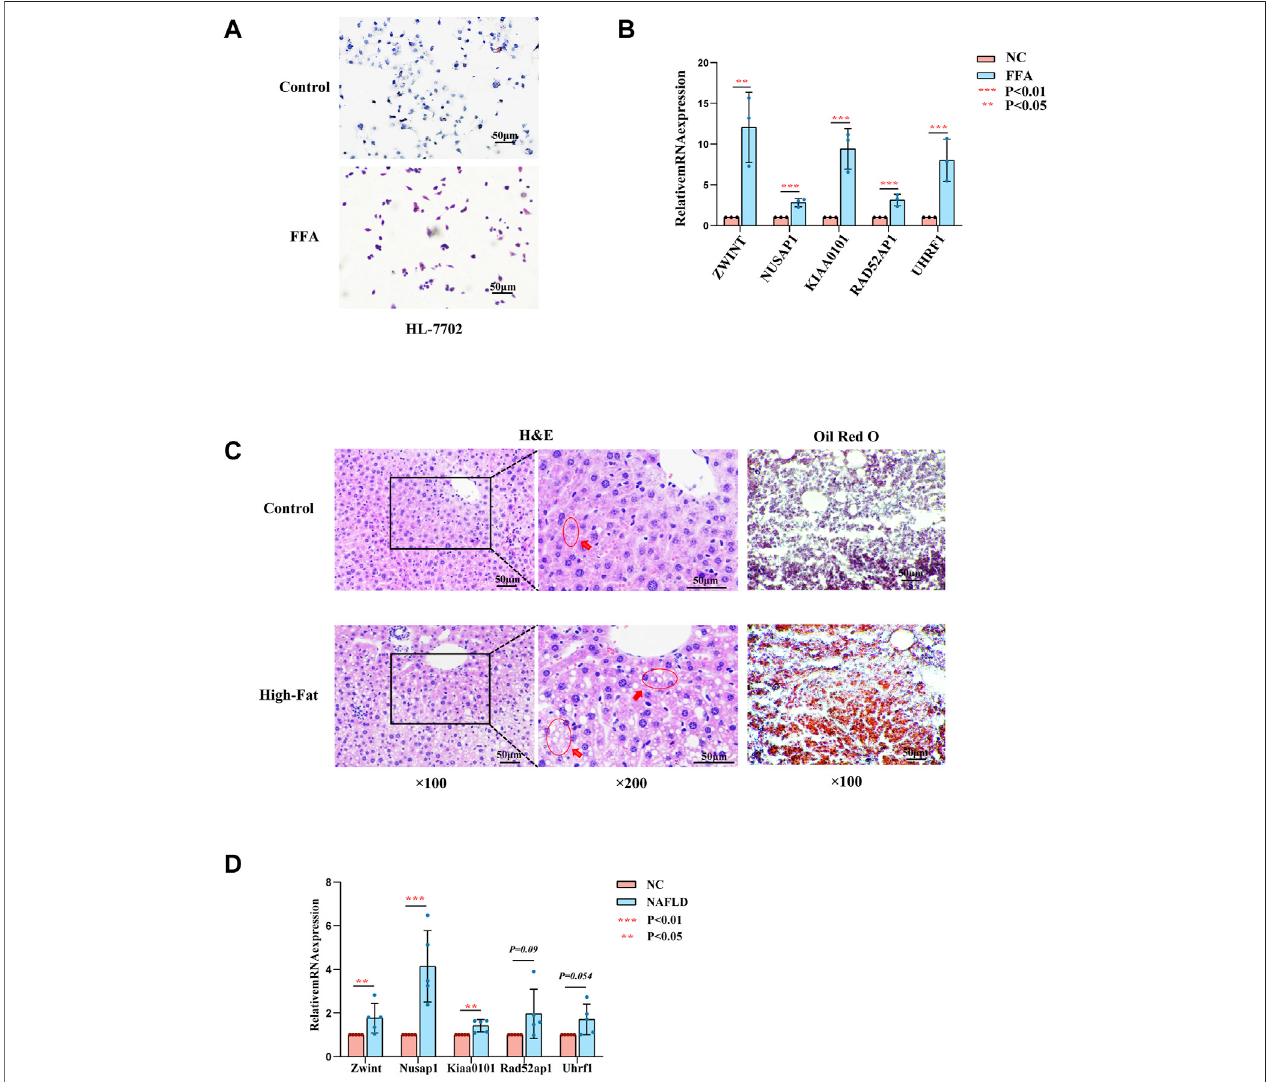
FIGURE 5 | Experiments in vitro and in vivo . (A) Represent Oil Red O staining of HL-7702 cells treated with or without FFA for 24 h. (B) Expression levels of hub genes in HL-7702 cells treated with FFA for 24 h was assessed by RT-PCR ( n = 3). (C) Represent HE (left, middle) and Oil Red O staining (right) of showing hepatic steatosis in liver tissues. 100 ⅹ for the HE images (left), 200 ⅹ for the HE images (midddle) and Oil red O images (right). (D) Expression levels of hub genes in NAFLD mice was assessed by RT-PCR ( n = 3 – 5).